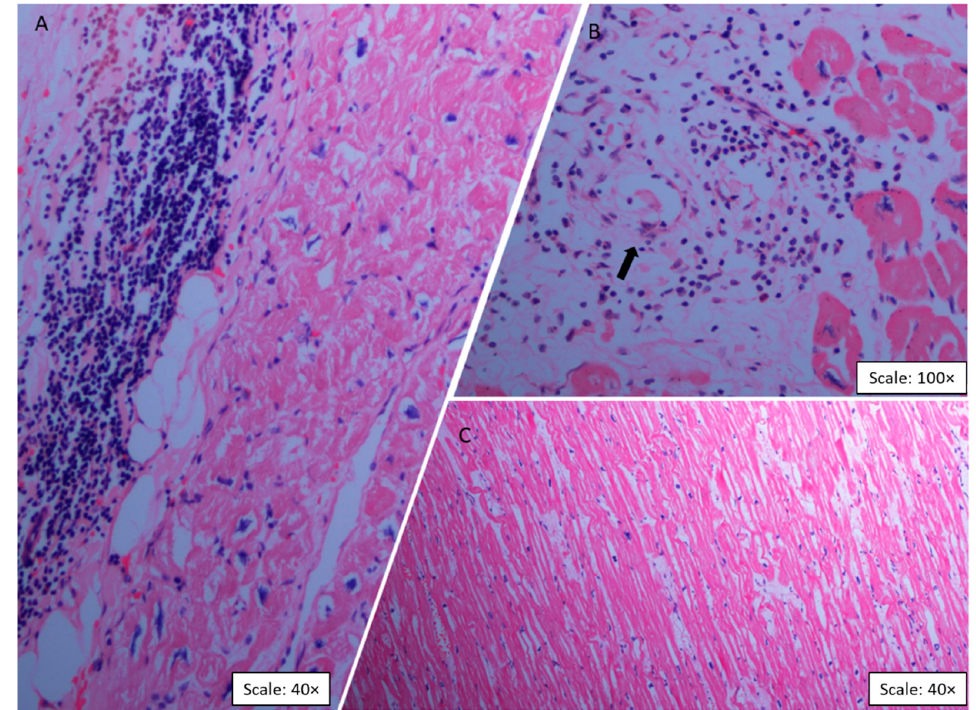
Figure 1. Representative histopathological findings on cardiac tissue sections with hematoxylin–eosin staining. Panels A and B correspond to cardiac muscle sections from patients with CCC. ( A ) Intense interstitial and perivascular fibrosis, inflammatory infiltrate, and myocytolysis are observed. The inflammation, composed of numerous macrophages, lymphocytes, plasma cells, and fewer eosinophils, surrounds degenerated and necrotic cardiomyocytes (Scale: 40×). ( B ) Abundant mononuclear cell infiltration in interstitial tissue and necrosis of cardiomyocytes (Scale: 100×). The arrow indicates the presence of a mononuclear inflammatory infiltrate with perivascular and interstitial distribution. ( C ) Control group sample showing heart tissue with a normal histological structure (Scale: 40×).